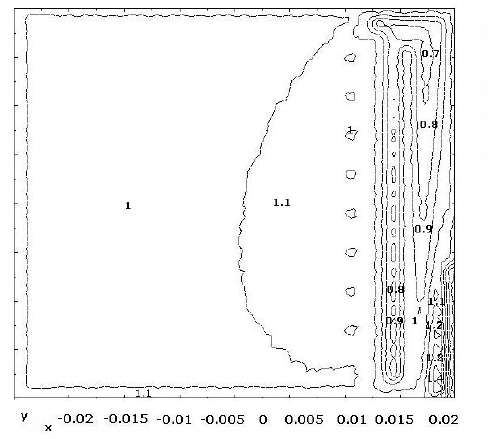
Figure 5. Contours lines of q(x,y) over the electrode surface. Results from the FLUENT PEMFC